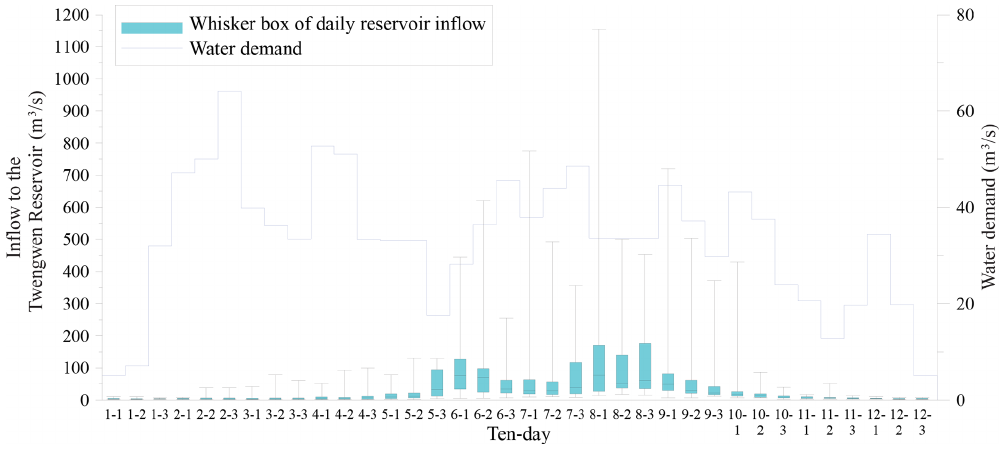
Figure 5. Demand and inflow patterns of Tsengwen Reservoir of all 10d periods throughout a